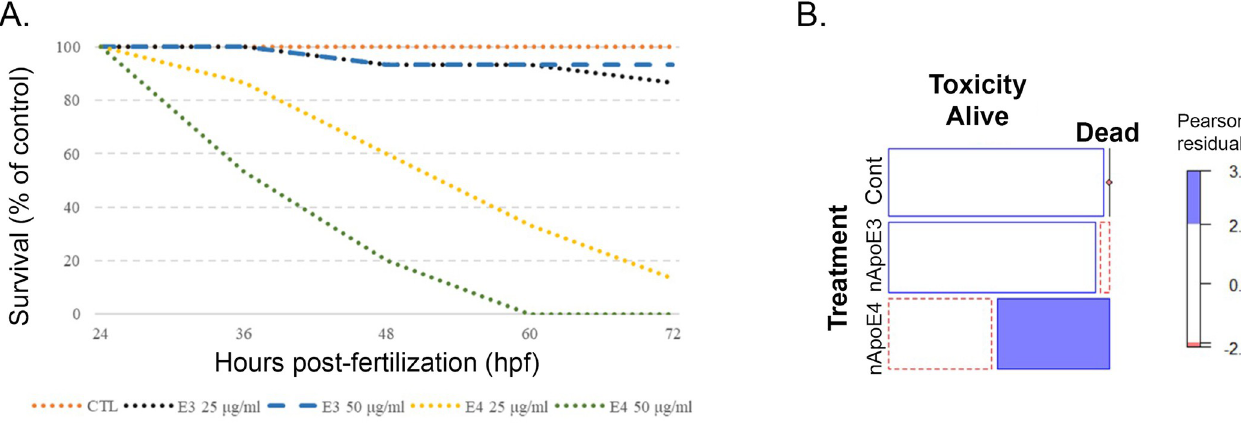
Fig 3. Survivability is decreased in zebrafish embryos following exogenous treatment with an amino-terminal fragment of nApoE4 1-151 . A. Embryos at 24 hpf (prim-9 stage) were segregated into three groups: controls (untreated), 25 μ g/ml or 50 μ g/ml nApoE3 1-151 , and 25 μ g/ml or 50 μ g/ml nApoE4 1-151 . Embryos that lacked a heartbeat for 10 seconds were stimulated to induce movement. If no movement or heartbeat was detected, embryos were considered to be non- viable. Significant mortality was observed at both concentrations of nApoE4 1-151 by 48 hpf (orange and green dotted lines) compared to non-treated controls (orange dotted line) or nApoE31-151 (blue dashed line and black dotted lines). N = 3 independent trials, N = 5 fish/treatment. B. The Mosaic Plot depicts mortality based on a lack of heartbeat and response to physical stimuli following exogenous treatment of 48 hpf zebrafish embryos with either 25 μ g/ml nApoE3 1-151 or nApoE4 1-151 for 24 hours. The blue filled region of the bar graph designates 25 μ g/ml treatment of nApoE4 1-151 which led to a significant portion of the embryos being designated as dead. The red dotted portion of the bar graphs indicates less than expected were alive (p = 1.17e-13). All blank cells indicate the sample group followed the estimated trend. Data indicated significant morality for only the nApoE4 1-151 group. N = 3 independent experiments, 15 embryos/treatment.